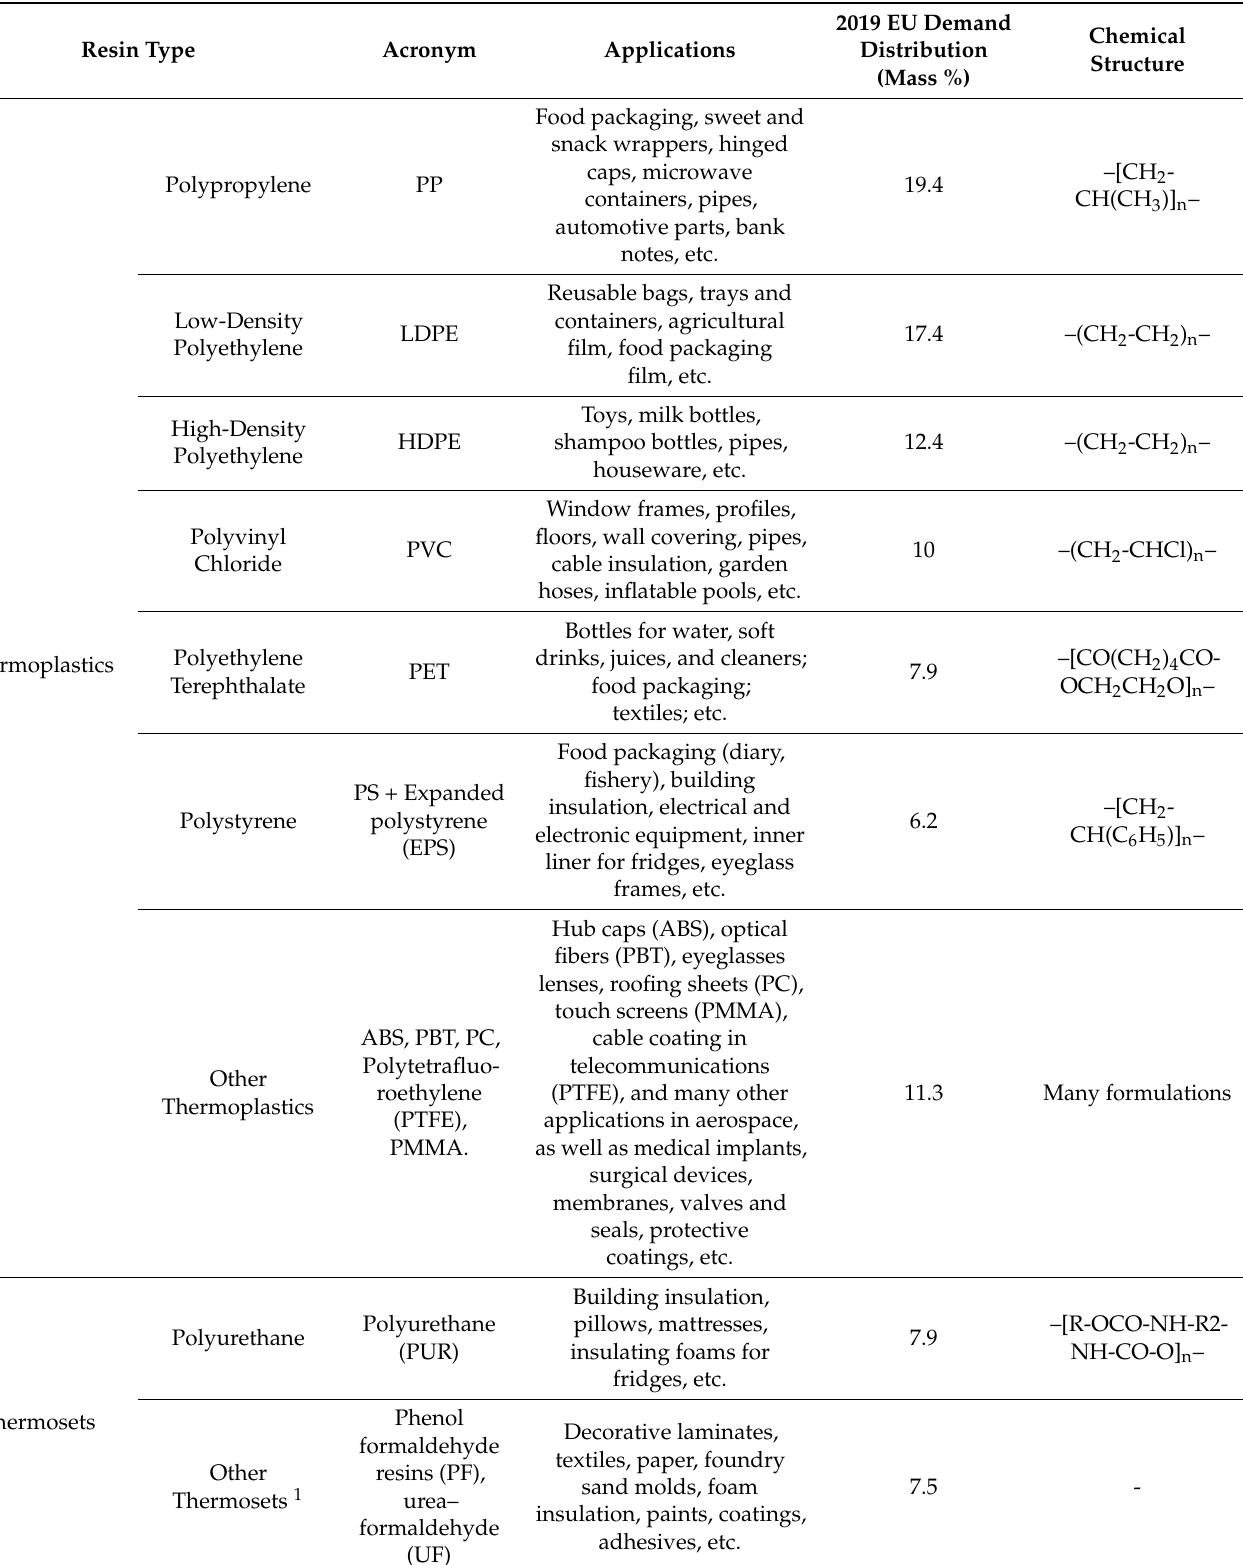
Table 2. Resin types and plastic demand distribution in 2019 (elaborated from